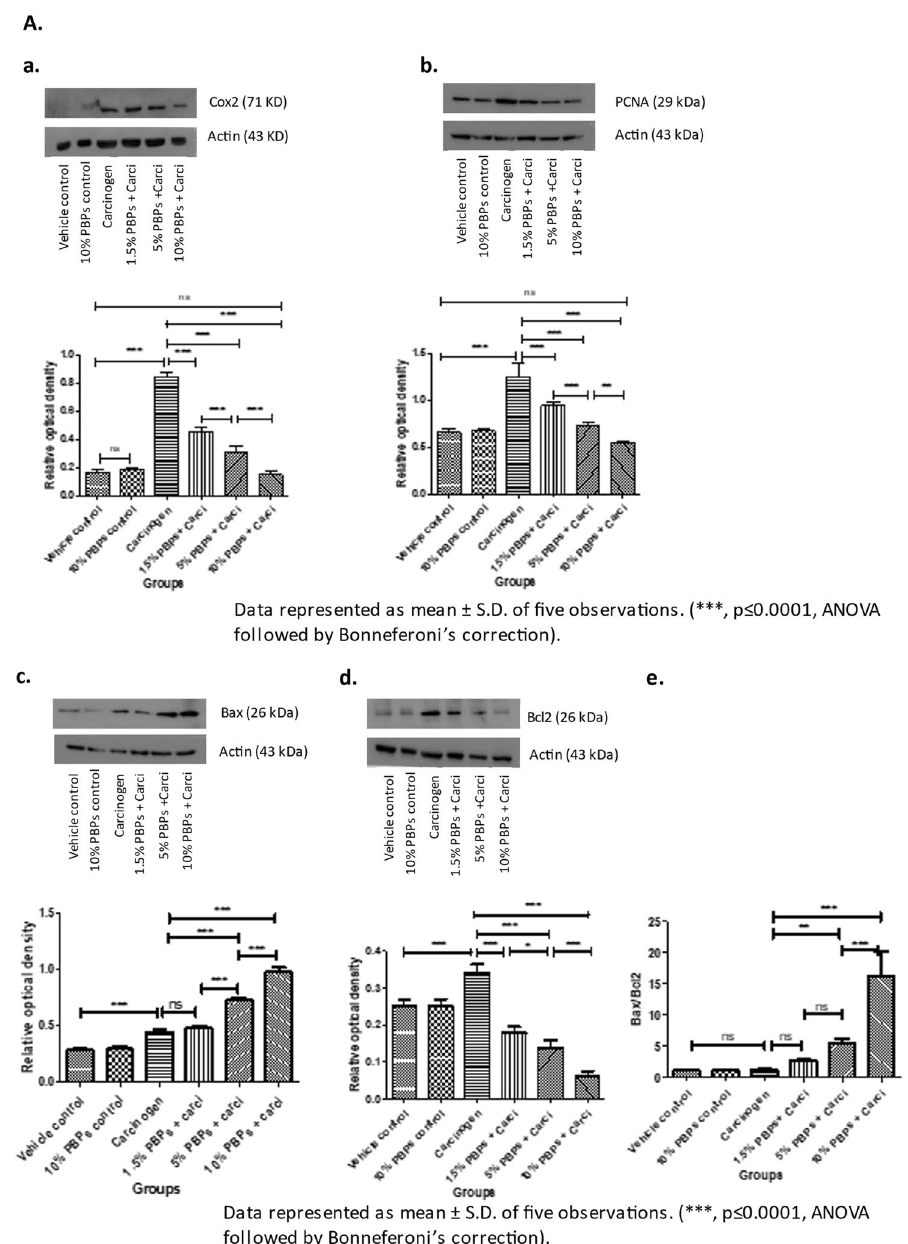
Figure 2. Effect of pre and concurrent treatment of different doses of PBPs on DNA damage, inflammation, proliferation, and apoptosis markers in experimental oral cancer. ( A ) Representative blots and relative densitometric levels of ( a ) Cox2, ( b ) PCNA, ( c ) Bax and ( d ) Bcl2. Data represented as mean ± S.D. of five observations. (***, p ≤ 0.0001, ANOVA followed by Bonneferoni’s correction). ( B ) Representative photomicrographs showing immunohistochemical detection of ( a ) 8-OHdG, ( b ) Cox-2 ( c ) PCNA and ( d ) Bax and ( e ) Bcl2. Data represented as mean ± S.D. of five observations. (***, p ≤ 0.0001, ANOVA followed by Bonneferoni’s